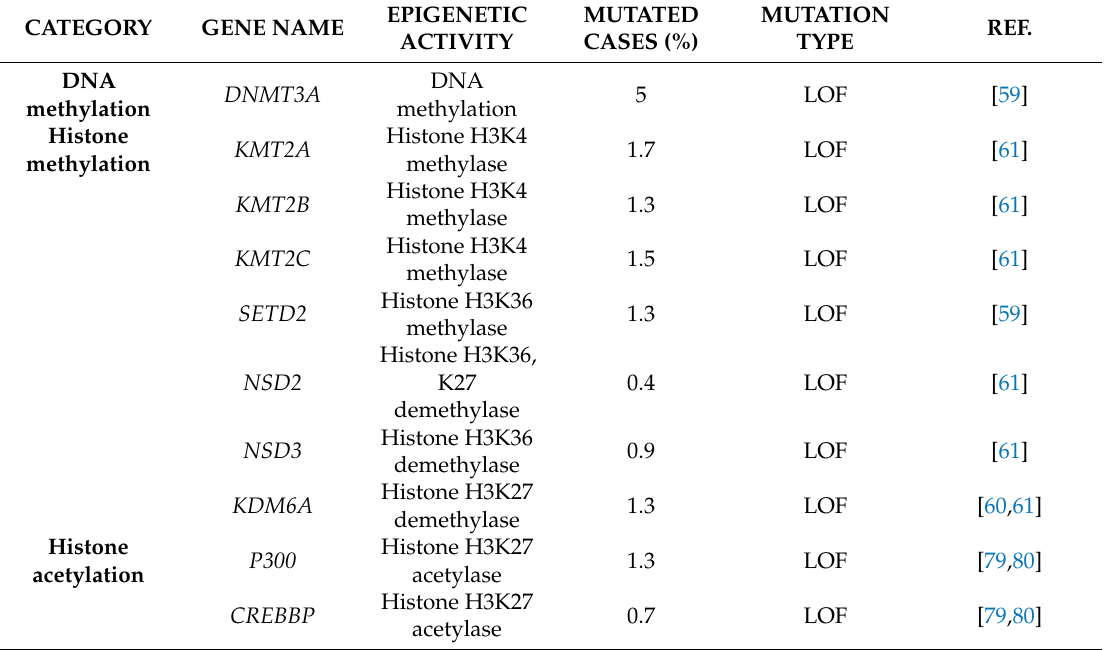
Table 1. Mutation of genes encoding for epigenetic